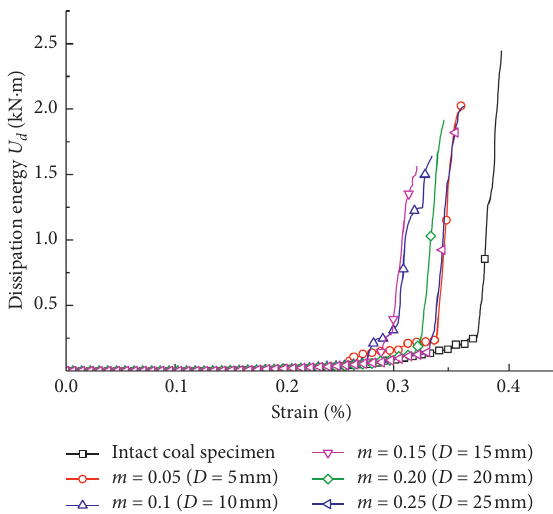
Figure 12: Curve of strain energy and